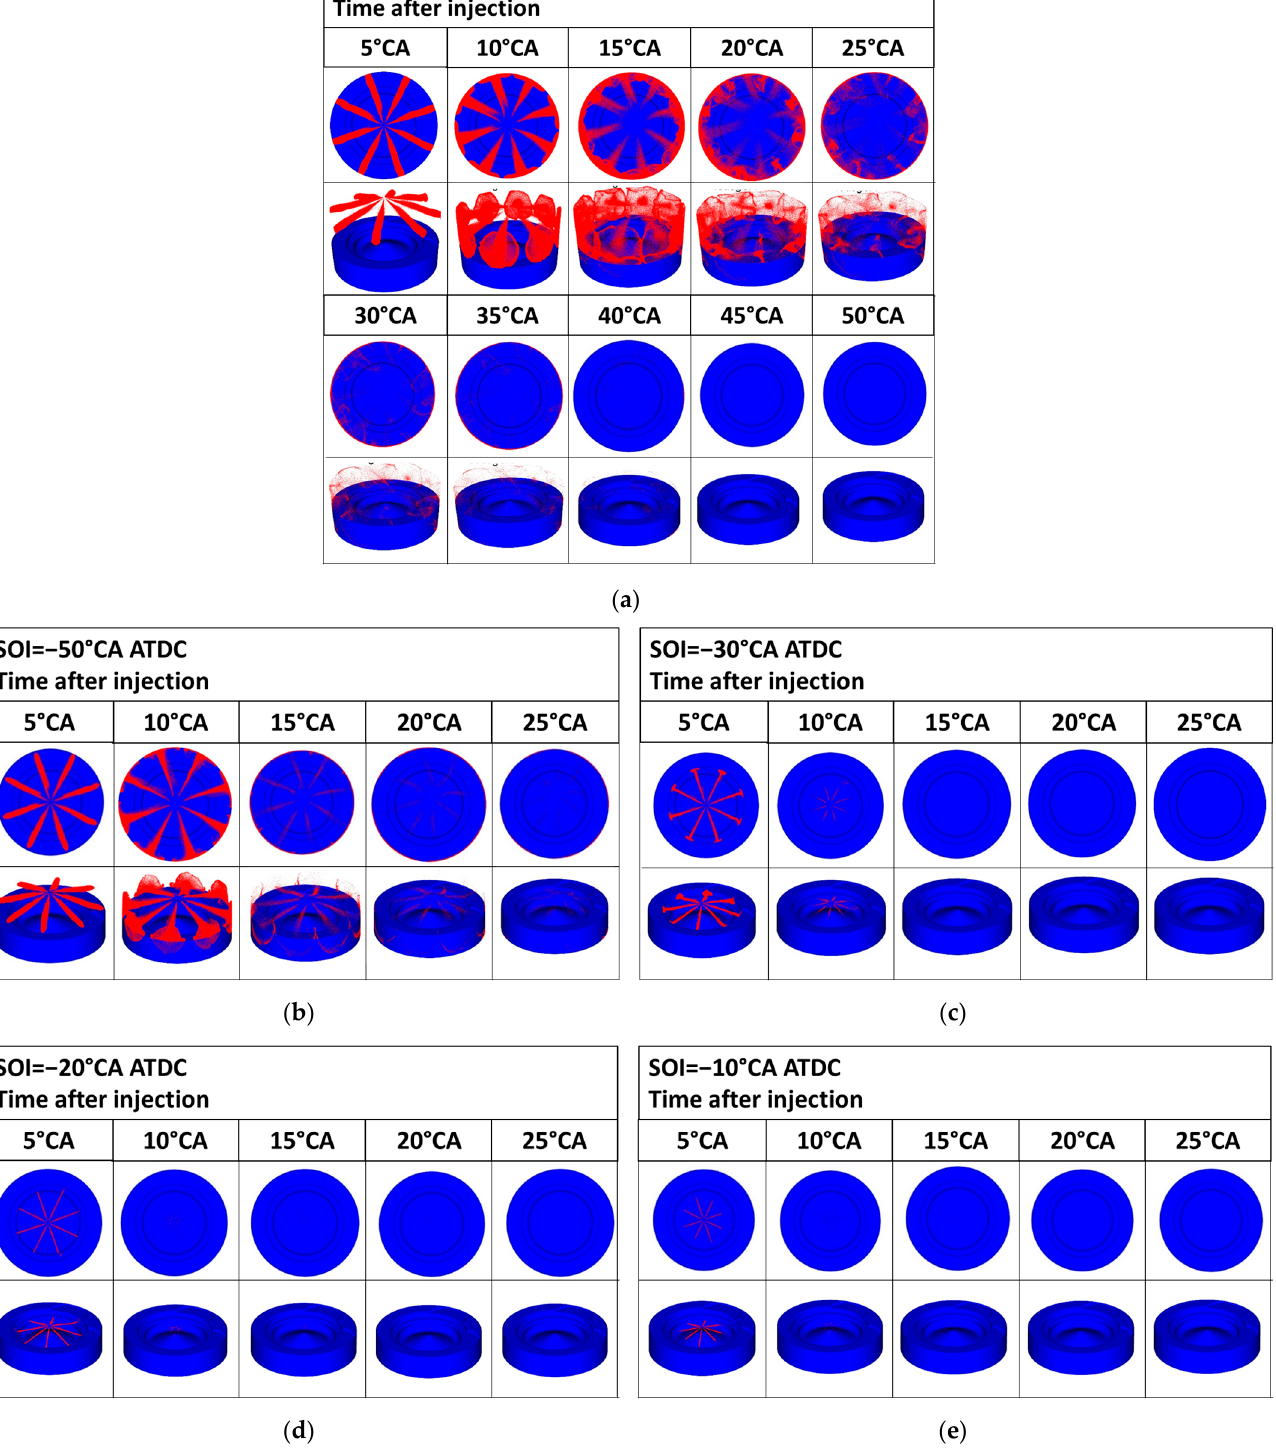
Figure 16. Spray tip penetration according to °CA ATDC after SOI for various injection timings. ( a ) SOI = − 70 °CA ATDC; ( b ) SOI = − 50 °CA ATDC; ( c ) SOI = − 30 °CA ATDC; ( d ) SOI = − 20 °CA ATDC; ( e ) SOI = − 10 °CA ATDC.